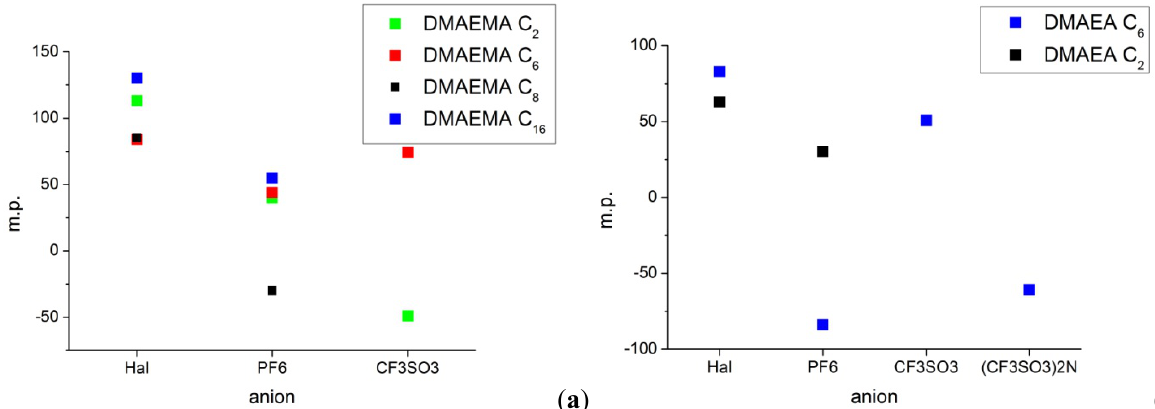
* Measured at 60 °C; ** Measured at 100 °C. and C alkyl chain length; ( c ) DEAEA with C 2 6